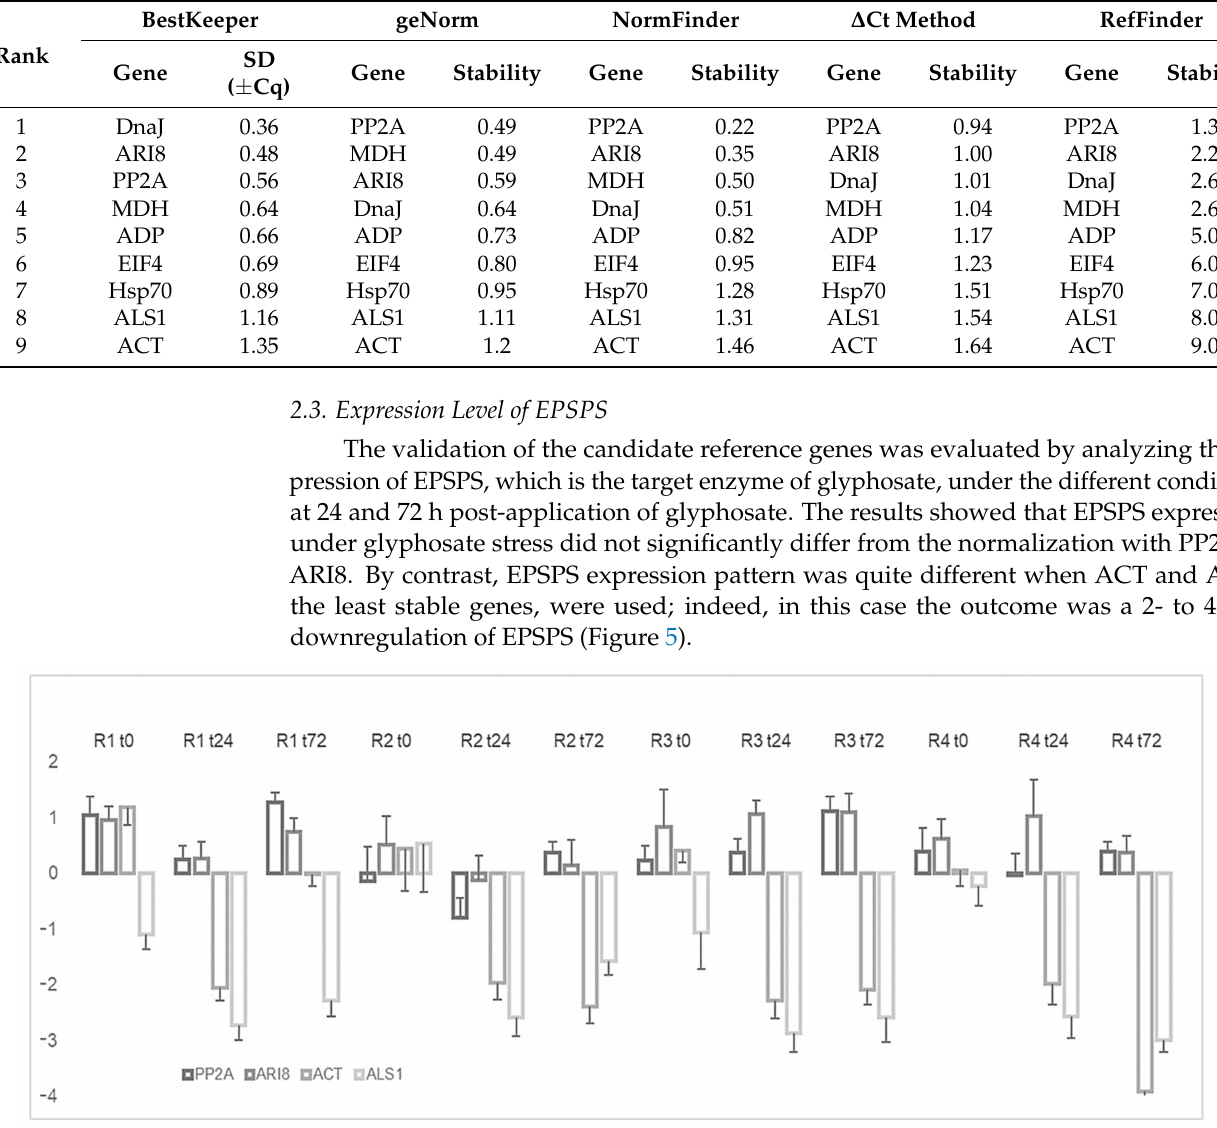
Table 3. Expression stability ranking of the nine candidate reference genes as calculated by RefFinder.